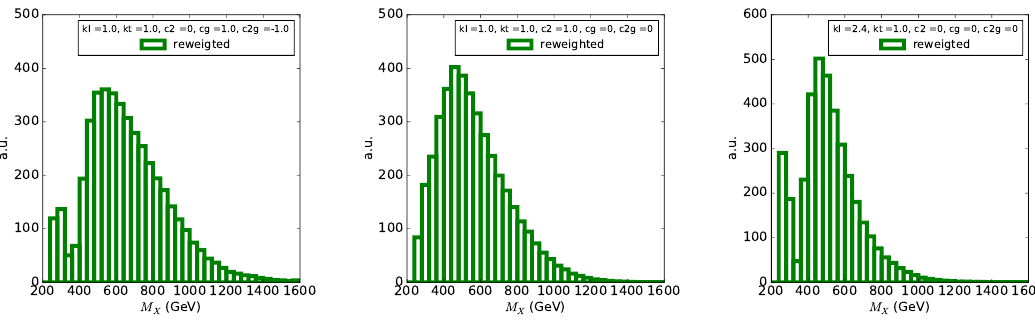
Figure 3 . Reconstructed variables after ATLAS-like selection for the m X variable for three BSM points with different kinematic properties. The histograms display the signal efficiency times 100,000